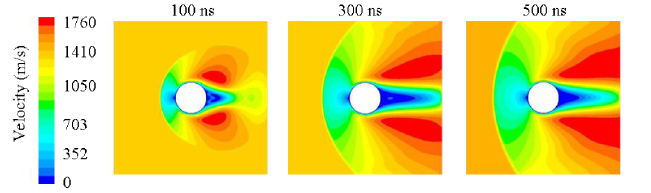
FIG. 2. The evolution of the velocity 100, 300, and 500 ns after inserting a cylinder into a Mach 1.5 free stream.